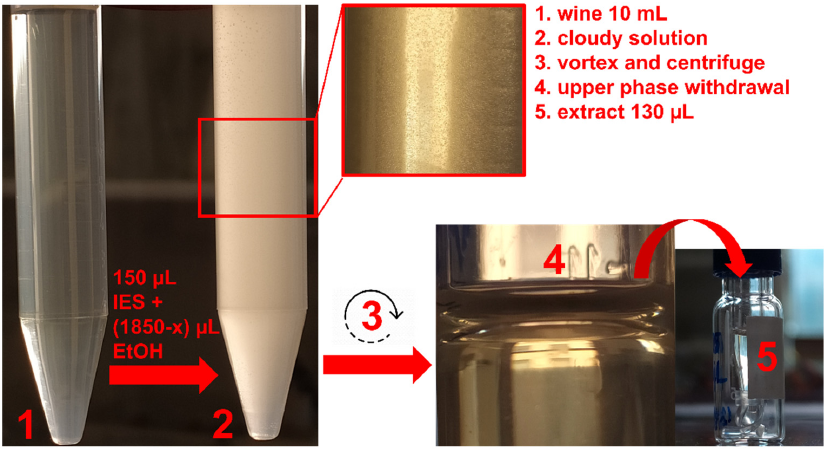
Figure 1. Scheme of the DLLME procedure on wine sample with a certain alcoholic content (x μ L of